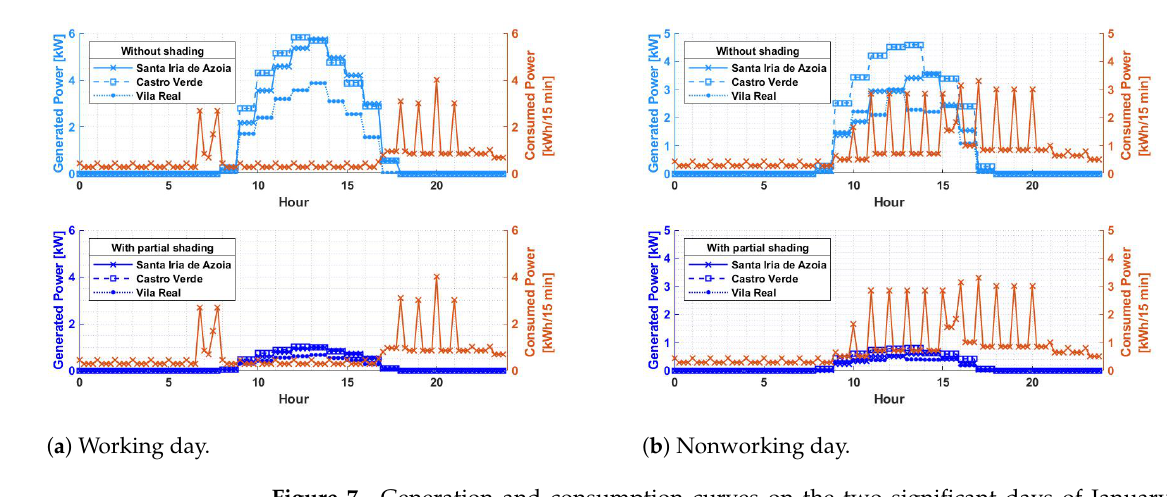
Figure 7. Generation and consumption curves on the two significant days of January for c-Si NWs technology.